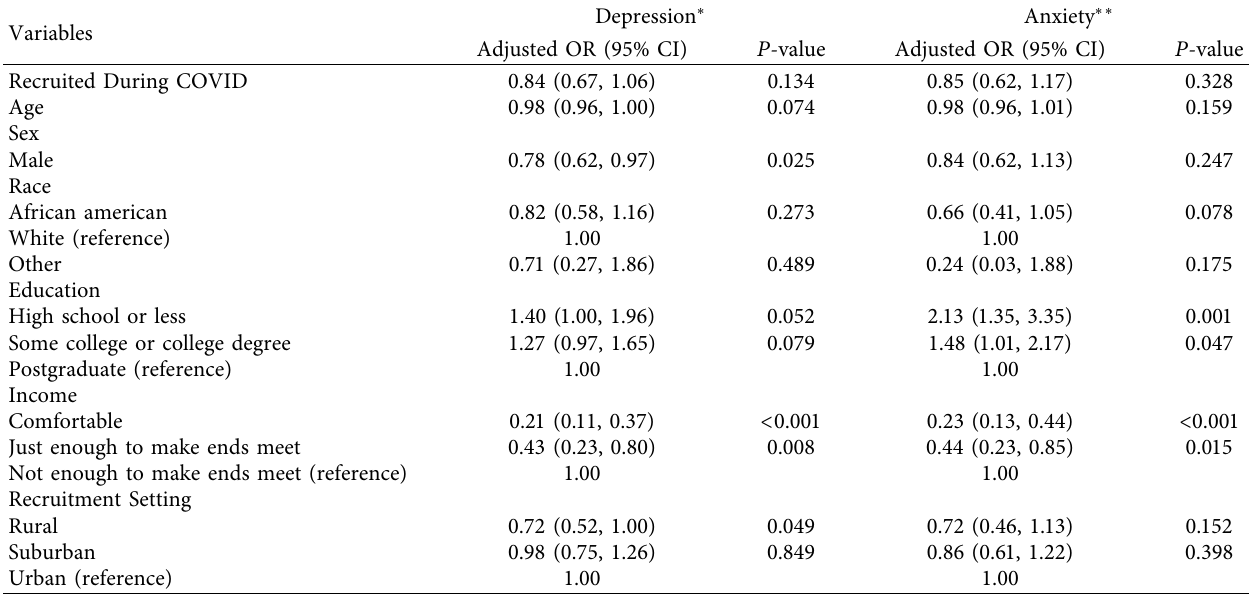
Table 2: Logistic regression results for patient depression and anxiety adjusting for patient